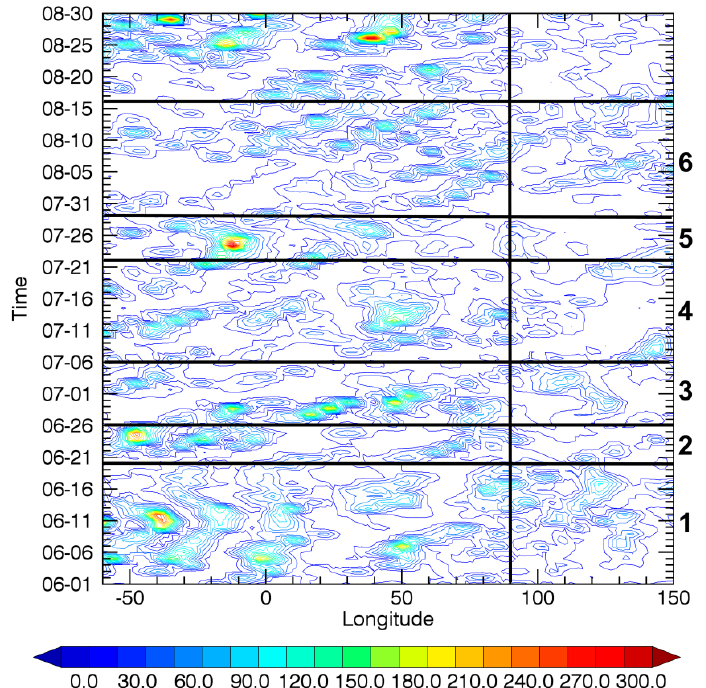
Figure 3. Horizontal (S) component of the WAF (m 2 s −2 ), according to Plumb equation (1985) for 50° N–70° N. The black vertical line is the western border of Eastern Siberia. Black horizontal lines are six-time interval boundaries: 1—preliminary period; 2—the first flood; 3—first forest fire large cluster formation; 4—second and third forest fire cluster formation and forest fire amplification; 5—the second flood; 6 –forest fire period, amplification forest fires activity. Era-Interim data.